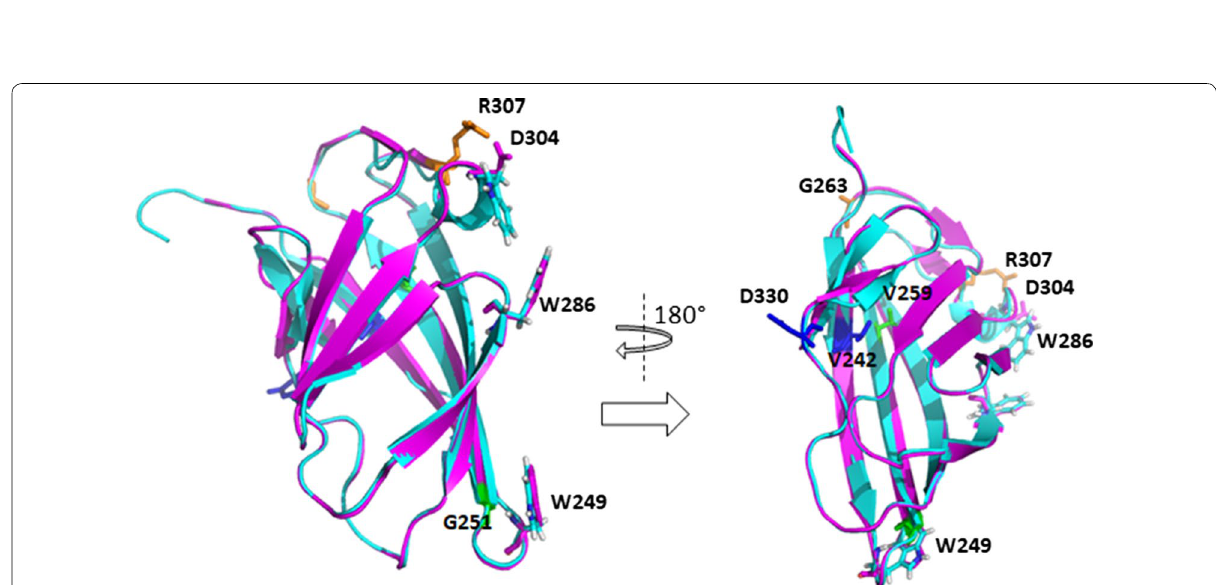
Fig. 3 Homology model of CBM structure of CelStrep overlaid to CBM of Cex from Cellulomonas fimi . Ribbon view of the structural overlay of the CBM of CelStrep (magenta) with the CBM of C. fini (cian). The three substrate binding tryptophan residues of C. fini are coloured in cian and the cor- responding residues, W249, W286 and D304 of Streptomyces sp. GH12 in magenta. The substituted labelled amino-acids are coloured according to the epCelStrep variant: epCS_1 (pink), epCS_4 (blue), epCS_5